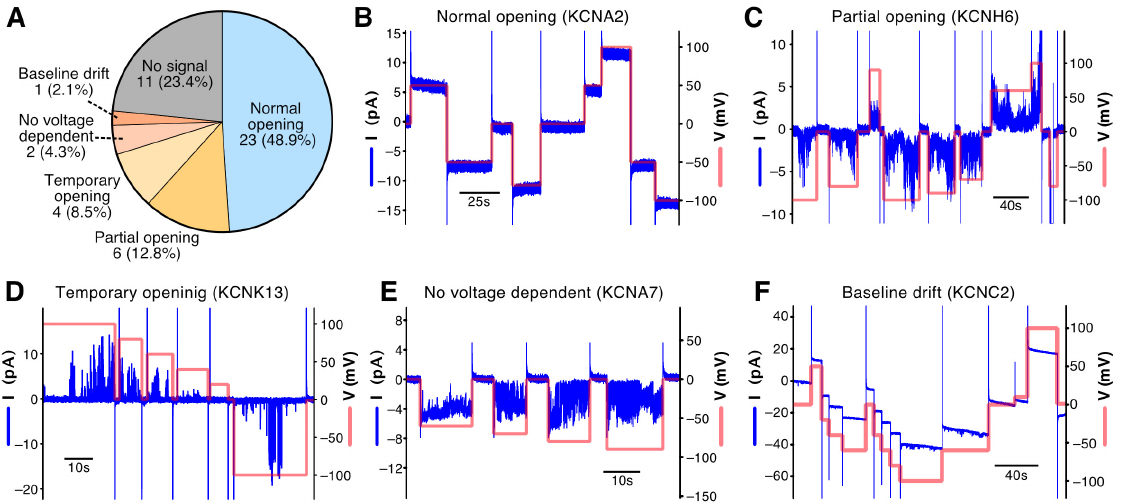
Figure 4. PLB assay of 47 cell-free synthesized voltage-gated K+ channels. ( A ) Summary of PLB assay. Representative current signals of normal opening ( B ), partial pore opening ( C ), temporary pore opening ( D ), no voltage-dependent opening ( E ), and baseline drift ( F ) are shown.